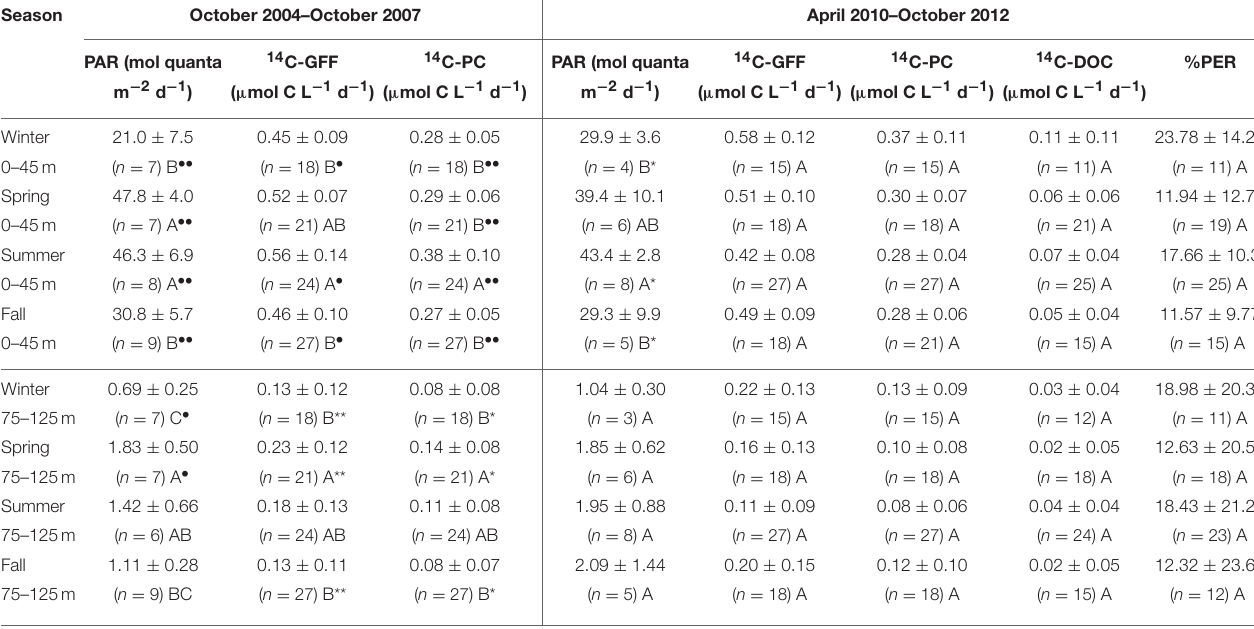
Mean irradiance (PAR) at the sea surface and at the 75m depth horizon and vertically-binned (0–45 and 75–125m) rates of 14 C-GFF and 14 C-PC from October 2004–October 2007, and from April 2010–October 2012. Also shown are vertically-binned 14 C-DOC and %PER ( 14 C-DOC / ( 14 C-DOC + 14 C-PC)) from April 2010–October 2012. Number of measurements (n) used to compute seasonal means shown in parentheses. Mean values denoted with the same letter are statistically indistinguishable. P-values are denoted with * p < 0.05, ** p < 0.005, • p < 0.001, and •• p <